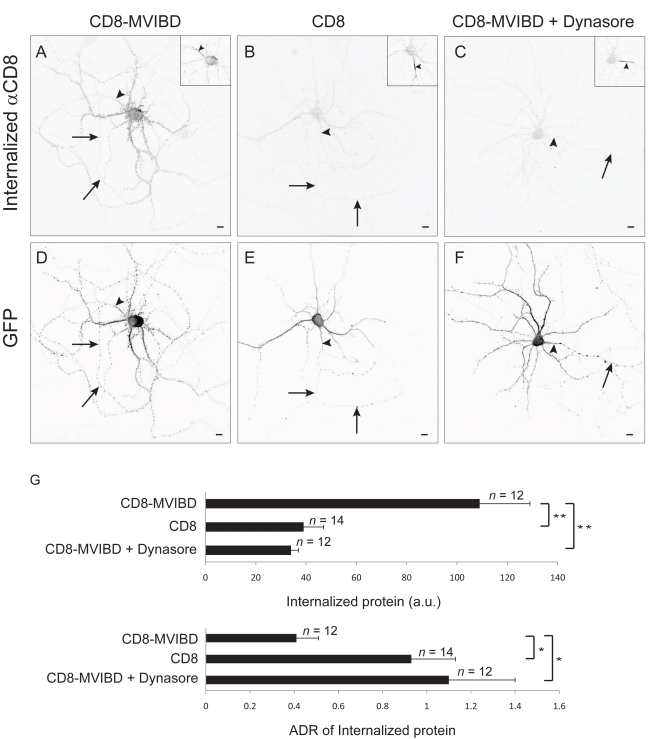
Interaction with Myosin VI promotes dendrite-specific endocytosis.(A) Internalized exogenous CD8-MVIBD that was labeled with anti-CD8 antibody and incubated for 30 min at 37°C in a cortical neuron in dissociated culture. Internalized protein was concentrated in the dendrites. (B) Internalized exogenous CD8 labeled under conditions identical to those in (A). (C) Internalized exogenous CD8-MVIBD labeled under conditions identical to those in (A), except with Dynasore, a blocker of endocytosis, included in the bath. (D–F) GFP labeling of the neurons in (A–C), respectively. Insets show staining of endogenous Ankyrin G. (G) Significantly more CD8-MVIBD than CD8 was internalized from cortical neurons in culture in a 30-min time frame. Internalization of CD8-MVIBD could be blocked by the presence of Dynasore in the medium. ADRs of CD8 versus CD8-MVIBD, which are significantly different, indicate that interaction with Myosin VI causes endocytosis to occur preferentially in the dendrites. ADRs of CD8-MVIBD in the presence versus absence of Dynasore were also significantly different. *, p<0.001; **, p<0.0003; Wilcoxon-Mann-Whitney test. Insets show staining of endogenous Ankyrin G. Arrows point to the axon; arrowheads point to the axon initial segment. Scale bars are 10 µm.